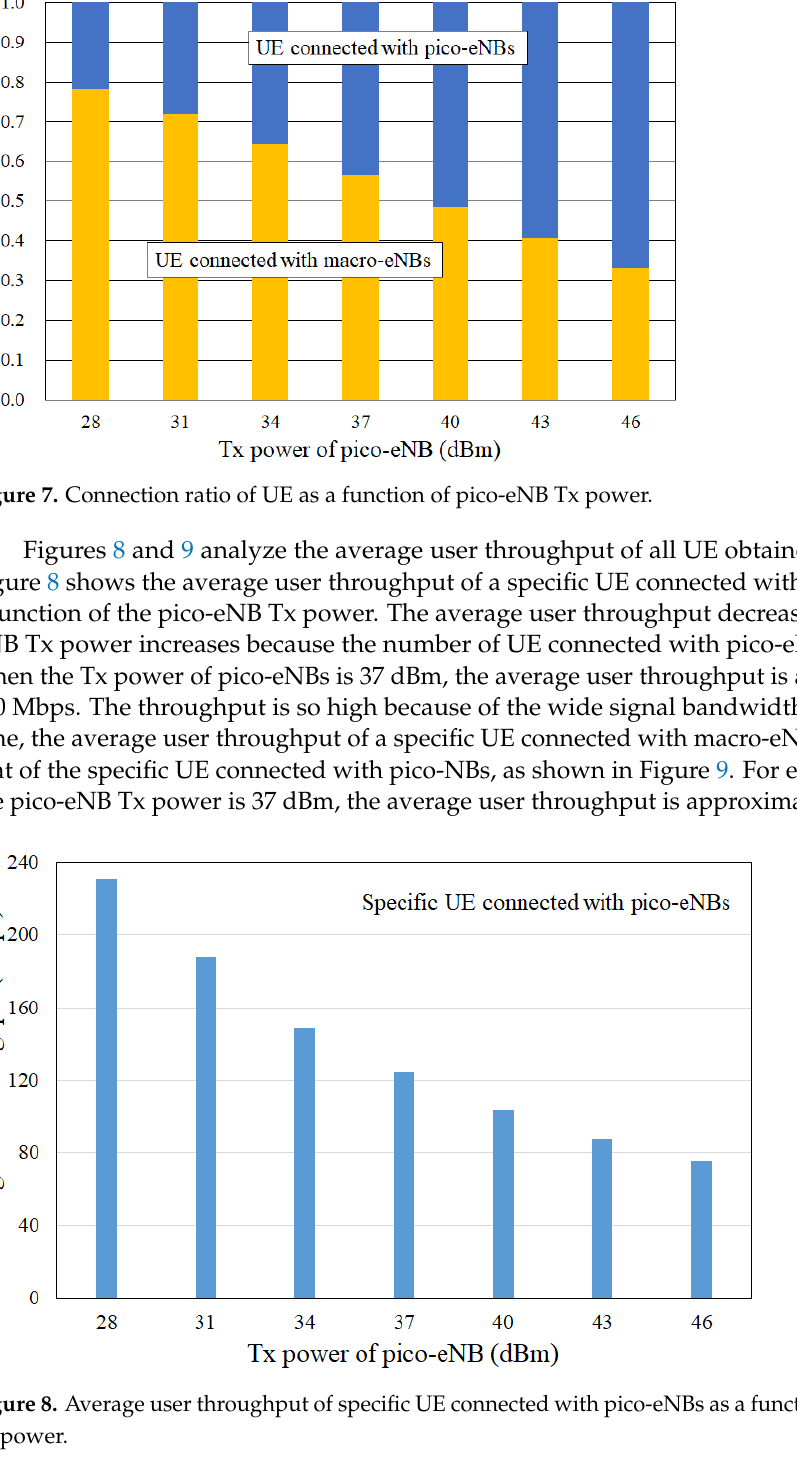
UE are connected with pico-eNBs in the 19 macrocells and the rest (975 pieces of UE) are connected with macro-eNBs. Figure 6. CDF of downlink effective SINR as a function of three pico-eNB Tx powers.